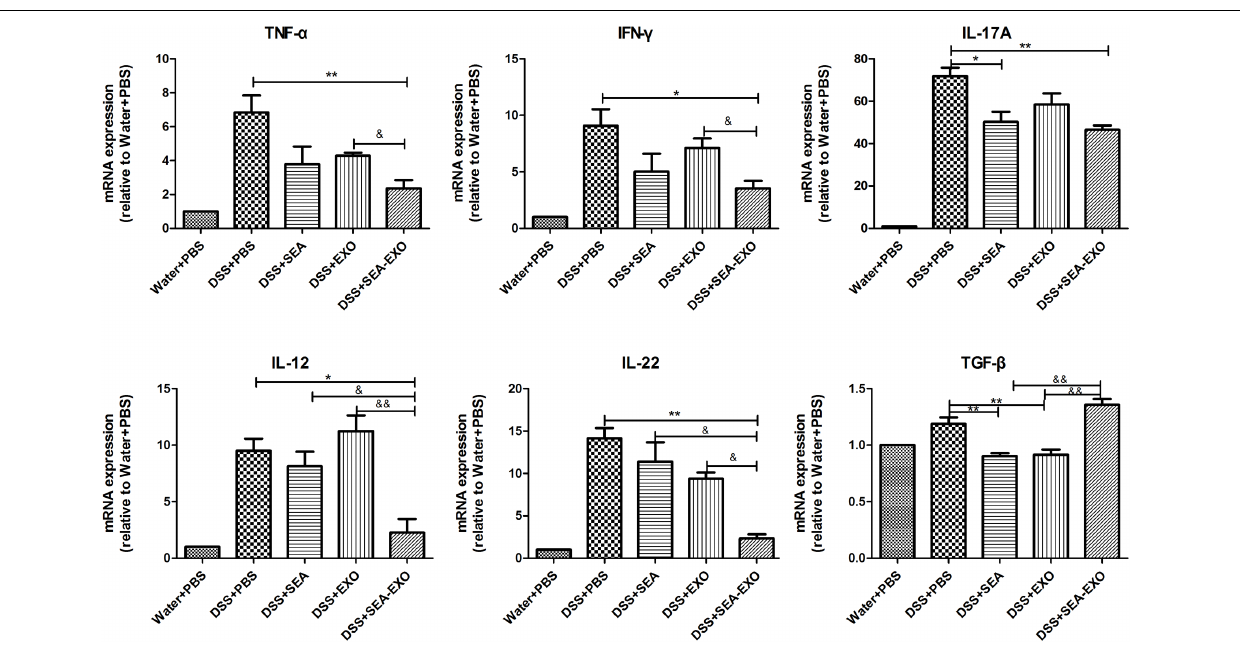
FIGURE 5 | Pro-inflammatory cytokine and immunoregulatory cytokine expression in the colons of acute DSS-induced colitis were determined by Real-time PCR. The mRNA expression levels of TNF- α , IFN- γ , IL-17A, IL-12, IL-22, and TGF- β were detected by Real-time PCR, the housekeeping gene GAPDH was used as internal reference. Statistical analyses of multiple groups were performed using a one-way ANOVA followed by Dunnett’s multiple comparison post hoc test versus DSS+PBS ( ∗ P < 0.05, ∗∗ P < 0.01). Statistical significance between two experimental groups was assessed using the Independent-Sample t -test ( & P < 0.05, && P <